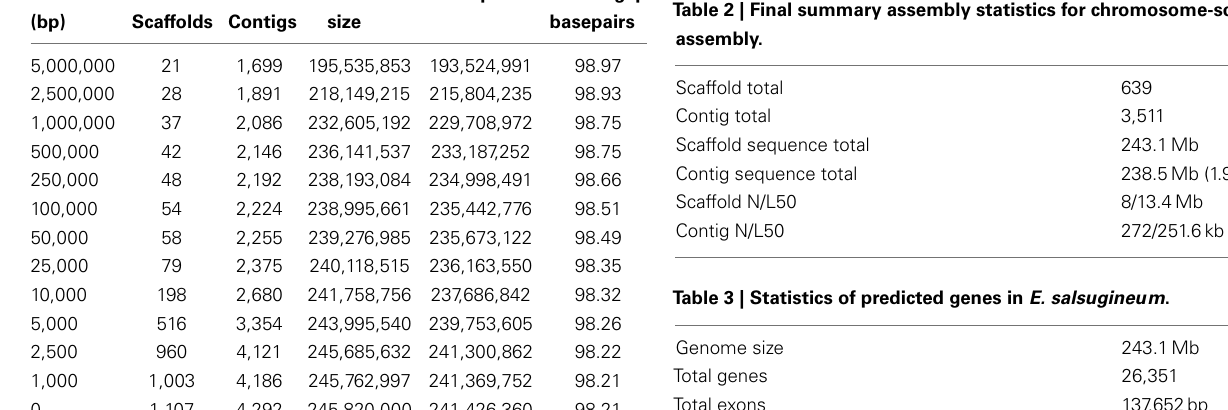
Table 2 | Final summary assembly statistics for chromosome-scale